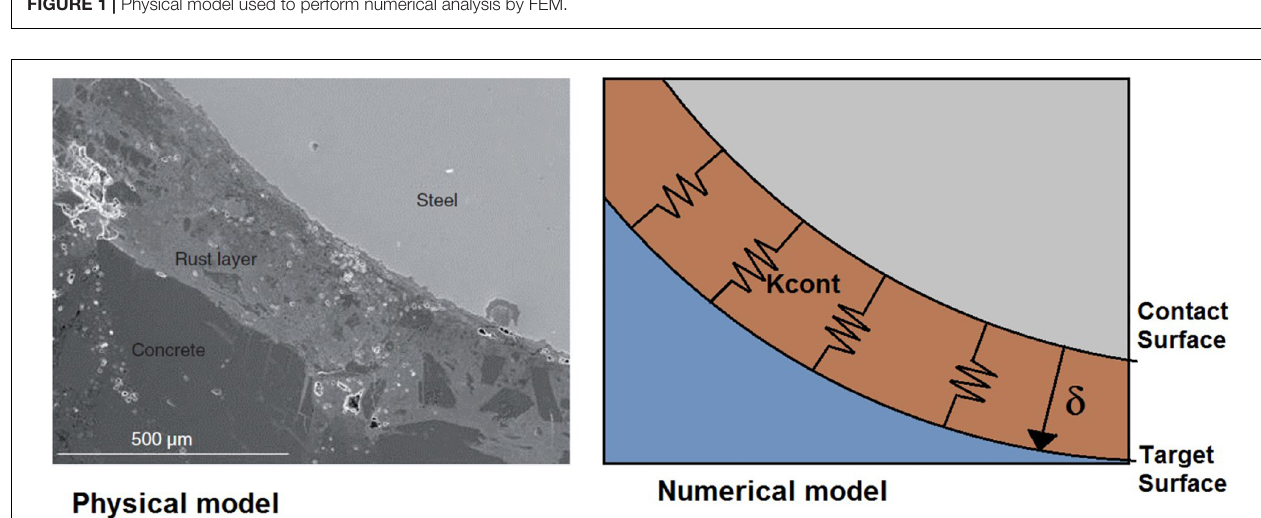
FIGURE 2 | Diagram of the steel-concrete interface, (left) physical model including rust layer, and (right) numerical model depicting the contact surface, target surface, contact stiffness (K cont ) and contact surface thickness ( δ